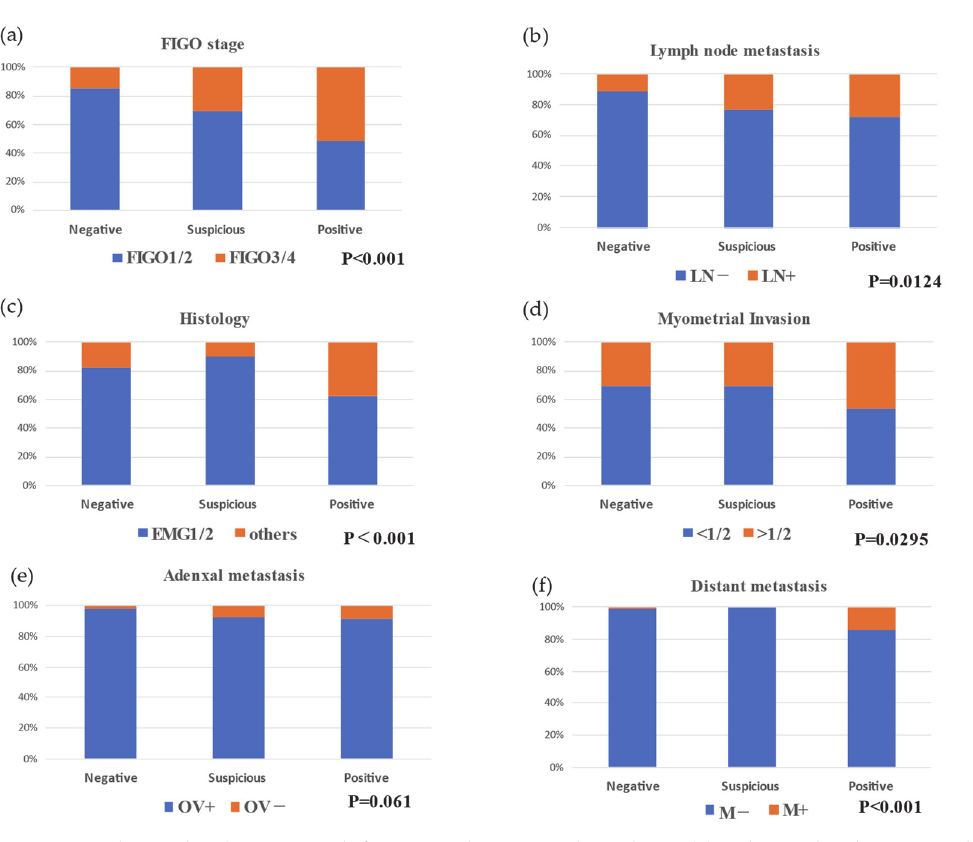
Figure 1. Relationship between risk factors and peritoneal cytology: ( a ) Relationship between ad- vanced stage and peritoneal cytology; ( b ) Relationship between lymph node metastasis and peritoneal cytology; ( c ) Relationship between histology and peritoneal cytology; ( d ) Relationship between myometrial invasion and peritoneal cytology; and ( e ) Relationship between adnexal metastasis and peritoneal cytology. FIGO, the International Federation of Gynecology and Obstetrics; EMG1/2/3, endometrioid cancer grade 1/2/3. ( f ) Relationship between distant metastasis and peritoneal cytol- ogy